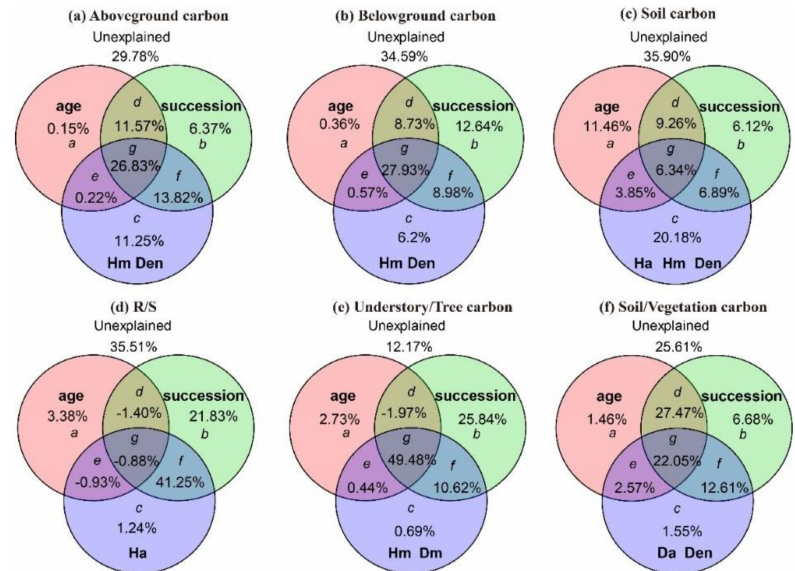
Figure 4. Variation partitioning analysis for the e ff ects of successional stage, stand age and stand factors on carbon storage (t C / hm 2 ) and allocation patterns. In the figure, a , b and c are the pure e ff ects of stand age, successional stages, and stand factors, respectively, while d , e , f and g are their shared e ff ects. Abbreviations for stand factors: Da, average DBH, Dm, maximum DBH; Ha, average height; Hm, maximum height, Den,